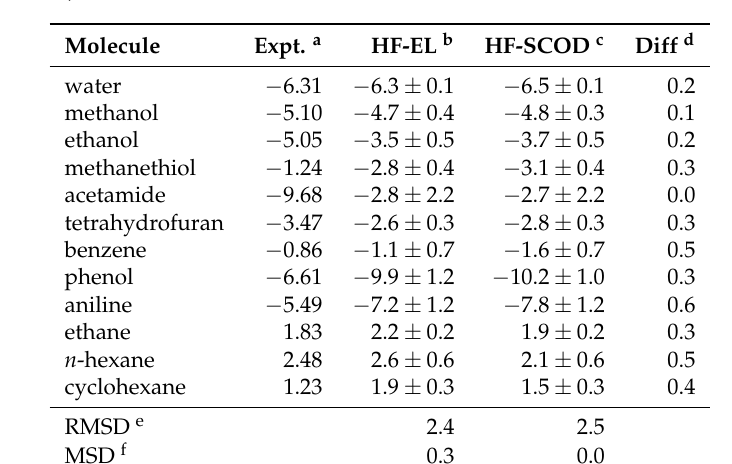
Table 4. Comparison of the QM/MM hydration free energies with Hartree–Fock based on the extended Lagrangian formalism (HF-EL) and with a self-consistent optimization of the Drude particles (HF-SCOD) in